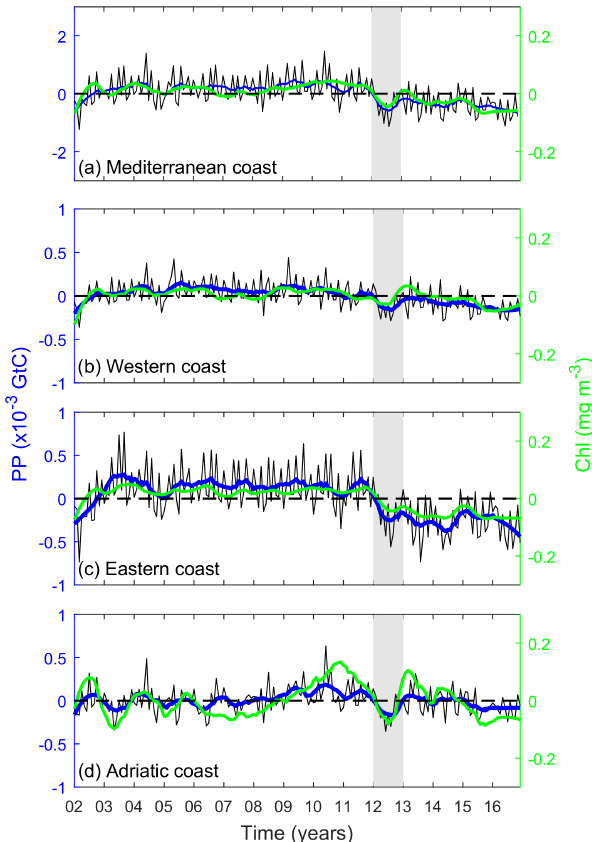
Figure 4. PP variability and trends for coastal waters in (a) the whole Mediterranean Sea, (b) western basin, (c) eastern basin, and (d) Adriatic coast. Black solid lines indicate the original monthly (cid:54) PP Coastal anomalies, and the filtered low-frequency signal is over- laid in blue (16-month width sgolay filter). Green solid lines indi- cate the filtered low-frequency signal for chl anomalies (mgm − 3 ). The red line indicates the PP trend during the analyzed period (2002–2016), and the gray band indicates the year 2012.